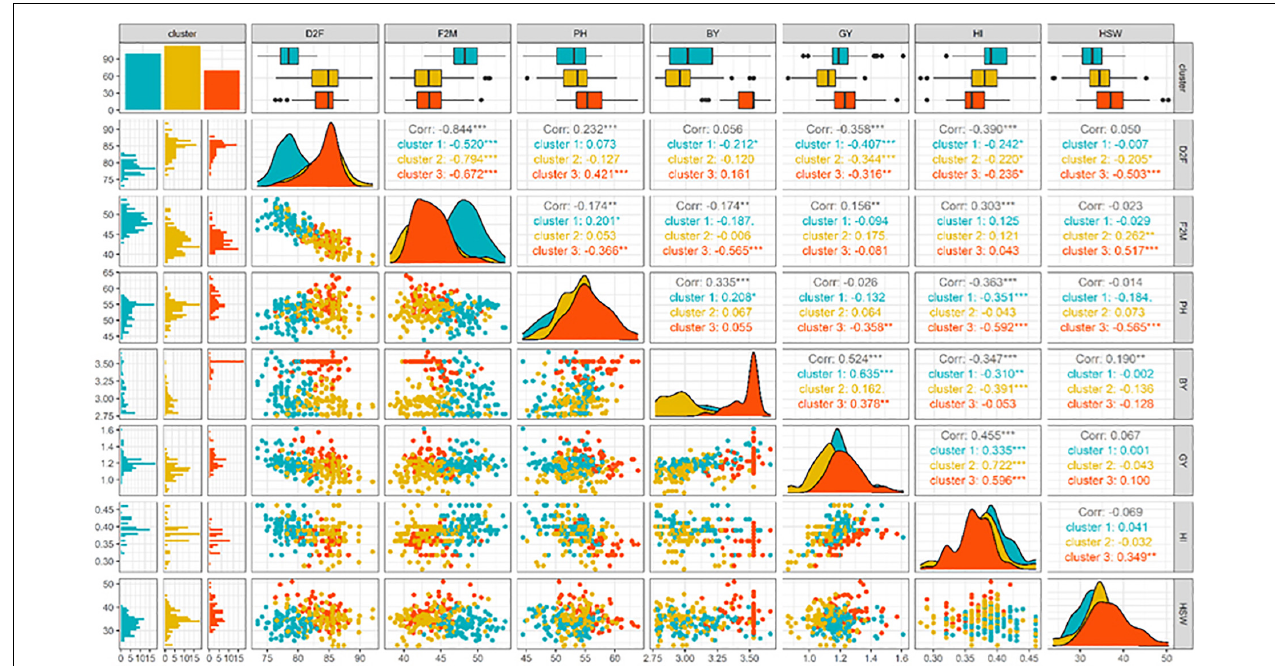
FIGURE 3 | Pairwise correlations between different agro-morpho-physiological parameters recorded for all chickpea tested genotypes.